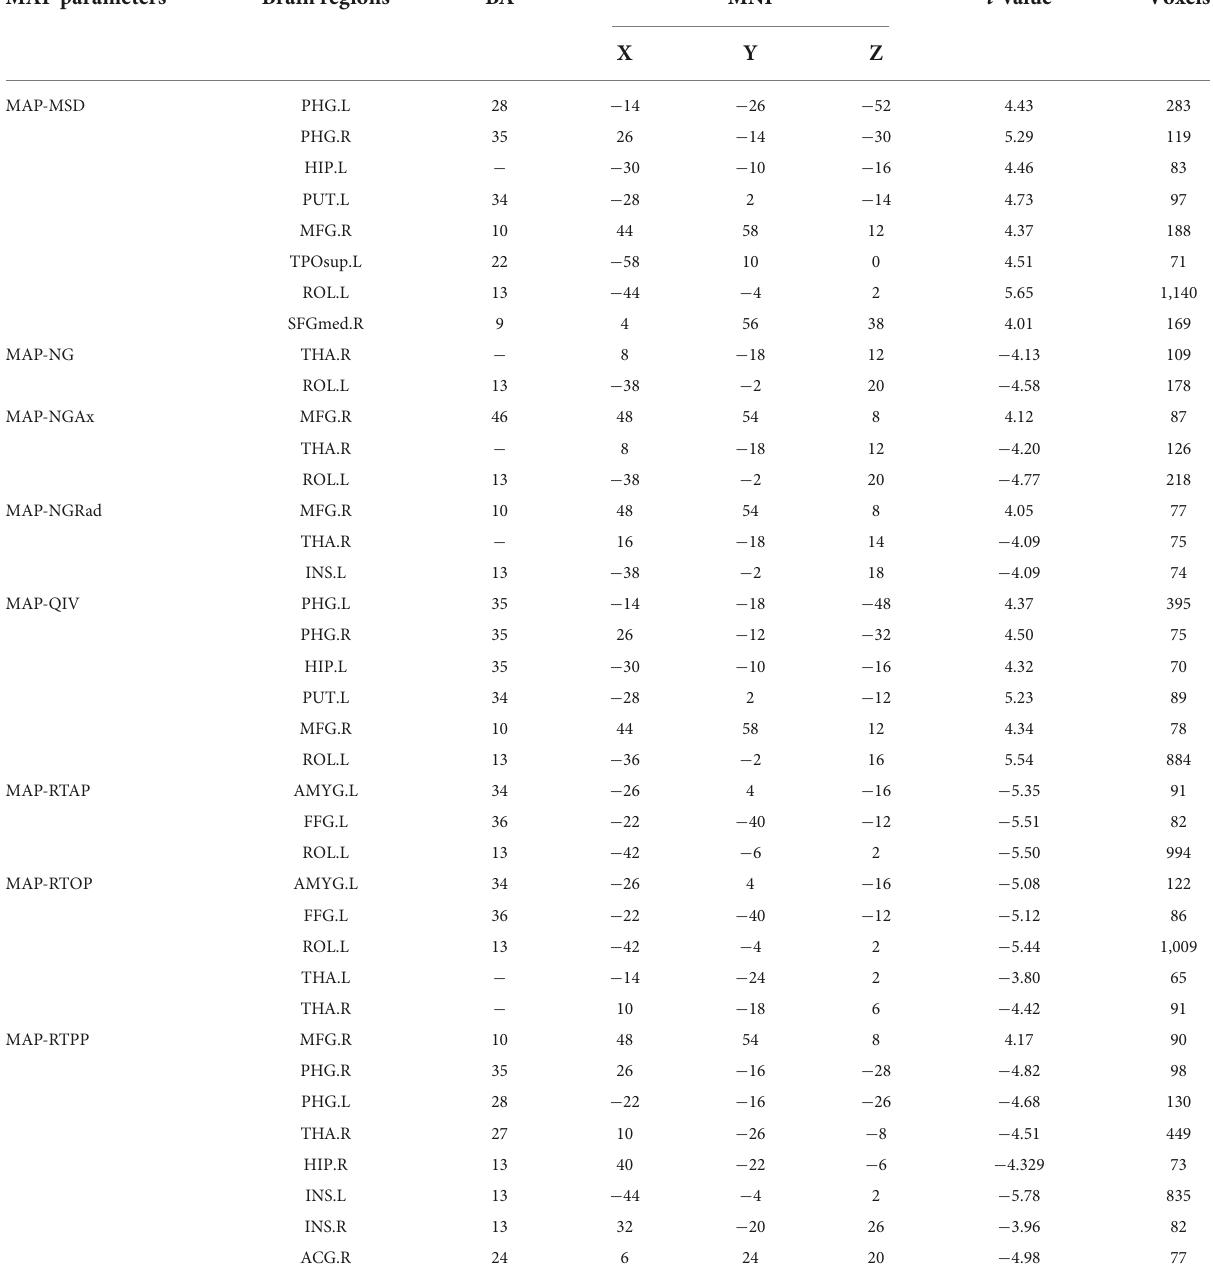
TABLE 2 Significant differences in the MAP parameters between CD patients and HCs. MAP